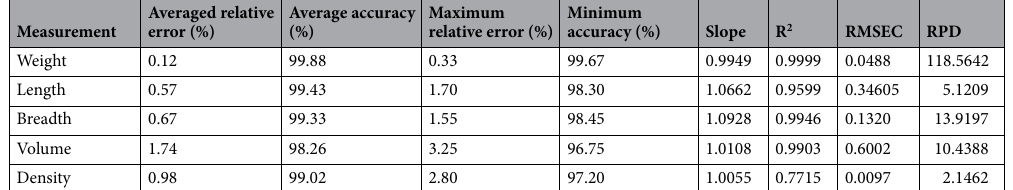
Table 1. The relative error, accuracy, statistical indicator and relationship of weight and external physical characteristic measurement of